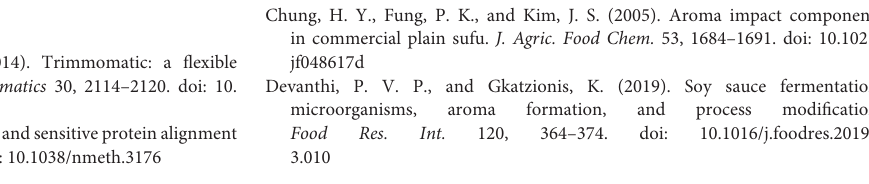
Supplementary Figure 1 | Koji making overview and sampling times. Supplementary Figure 2 | pH changes during koji making. Supplementary Figure 3 | Taxonomic composition of koji metagenomes at the phylum level showing changes in microbial communities across six fermentation stages (0–48 h). Sequences that could not be classified to known taxa were designated as “unclassified”. Supplementary Figure 4 | Functional profiles produced from whole shotgun metagenome-derived ORFs annotated at level 2 of the Kyoto Encyclopedia of Genes and Genomes (KEGG)